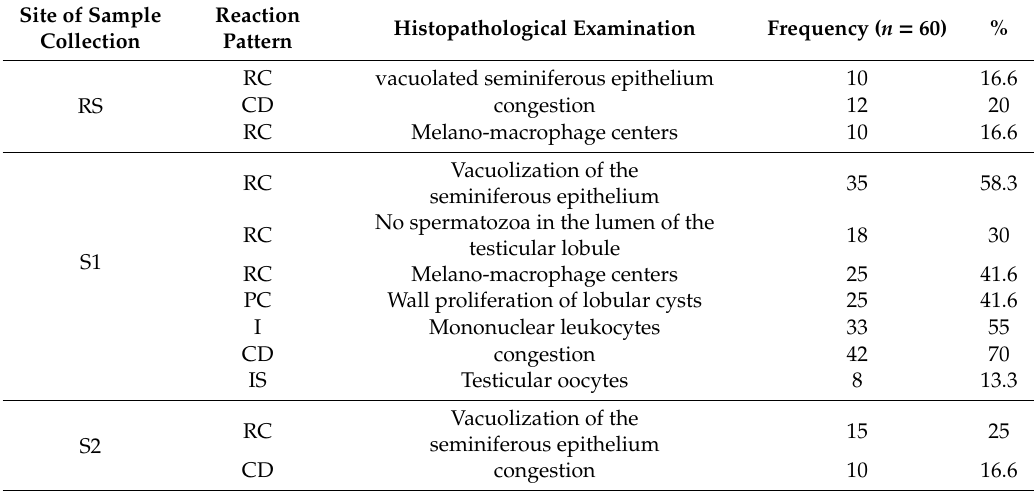
Table 2. Percentage prevalence of the histological alterations identified in the testes of Nile tilapia from sampling